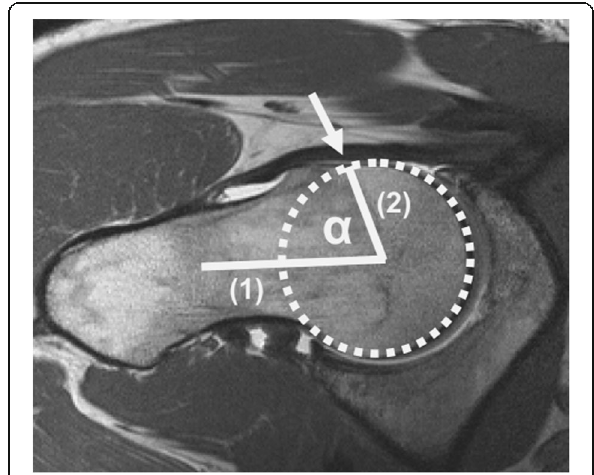
Fig. 2 Measurement of the alpha angle is shown. A best-fit circle is drawn over the femoral head. The alpha angle is formed by the axis of the femoral neck (1) and a line (2) drawn from the femoral head center to the point where the head extends beyond the margin of the best fit circle (arrow)